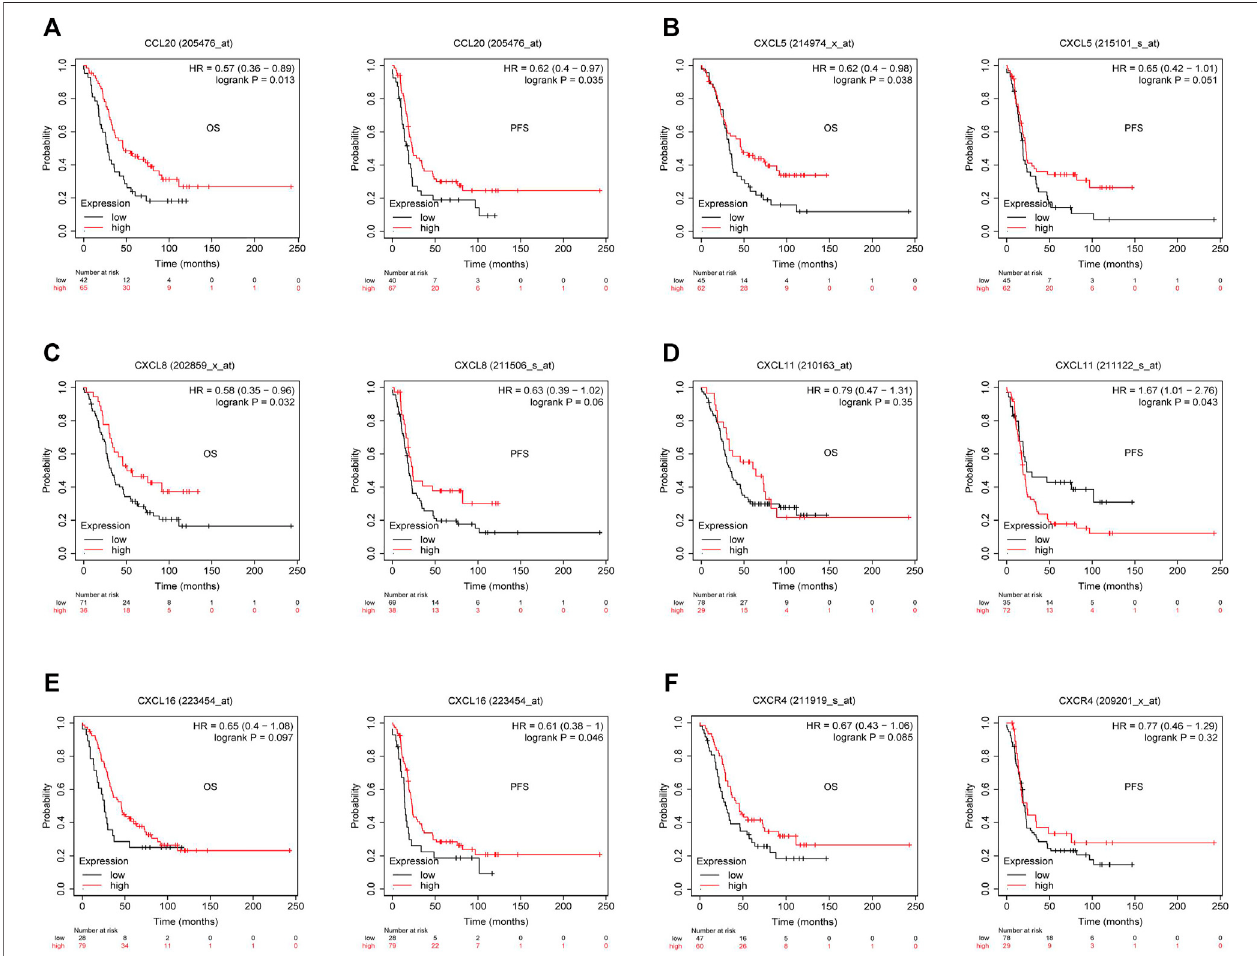
FIGURE 8 | Kaplan – Meier survival curve comparison of the high and low expression of corresponding chemokines and chemokine receptor in GSE26193. (A – C) High CCL20, CXCL5, and CXCL8 had better survival in OV. (D) Relationship between CXCL11 expression and survival in OV. (E) Overexpressed CXCL16 had longer survival in OV. (F) Relationship between CXCR4 expression and survival in OV ( p < 0.05).